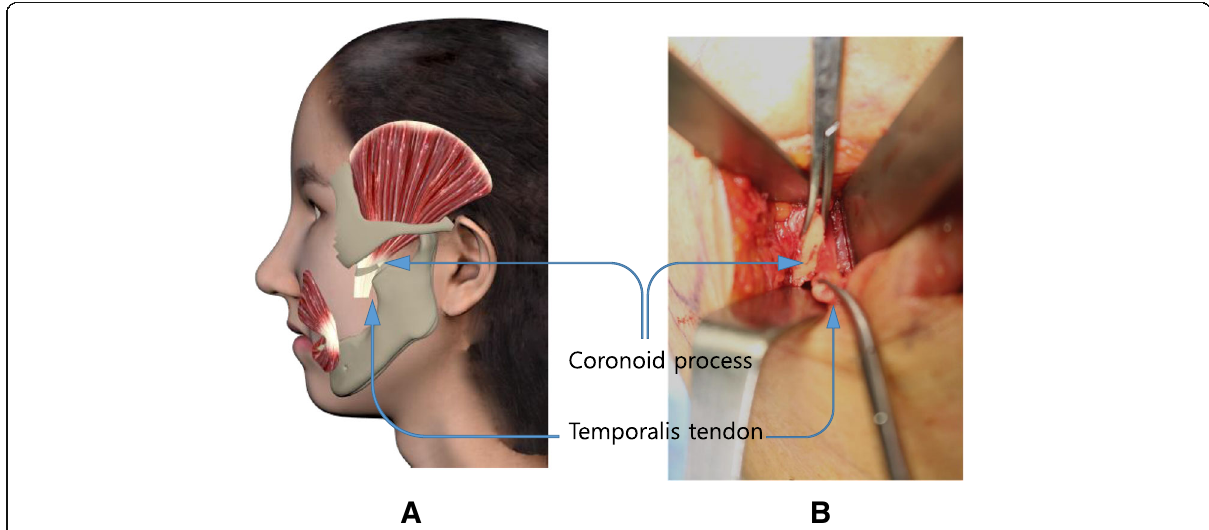
Fig. 2 Separation of temporalis tendon from mandible ramus ( a 3D simulation feature; b intraoperative view, separated temporalis tendon, and coronoid